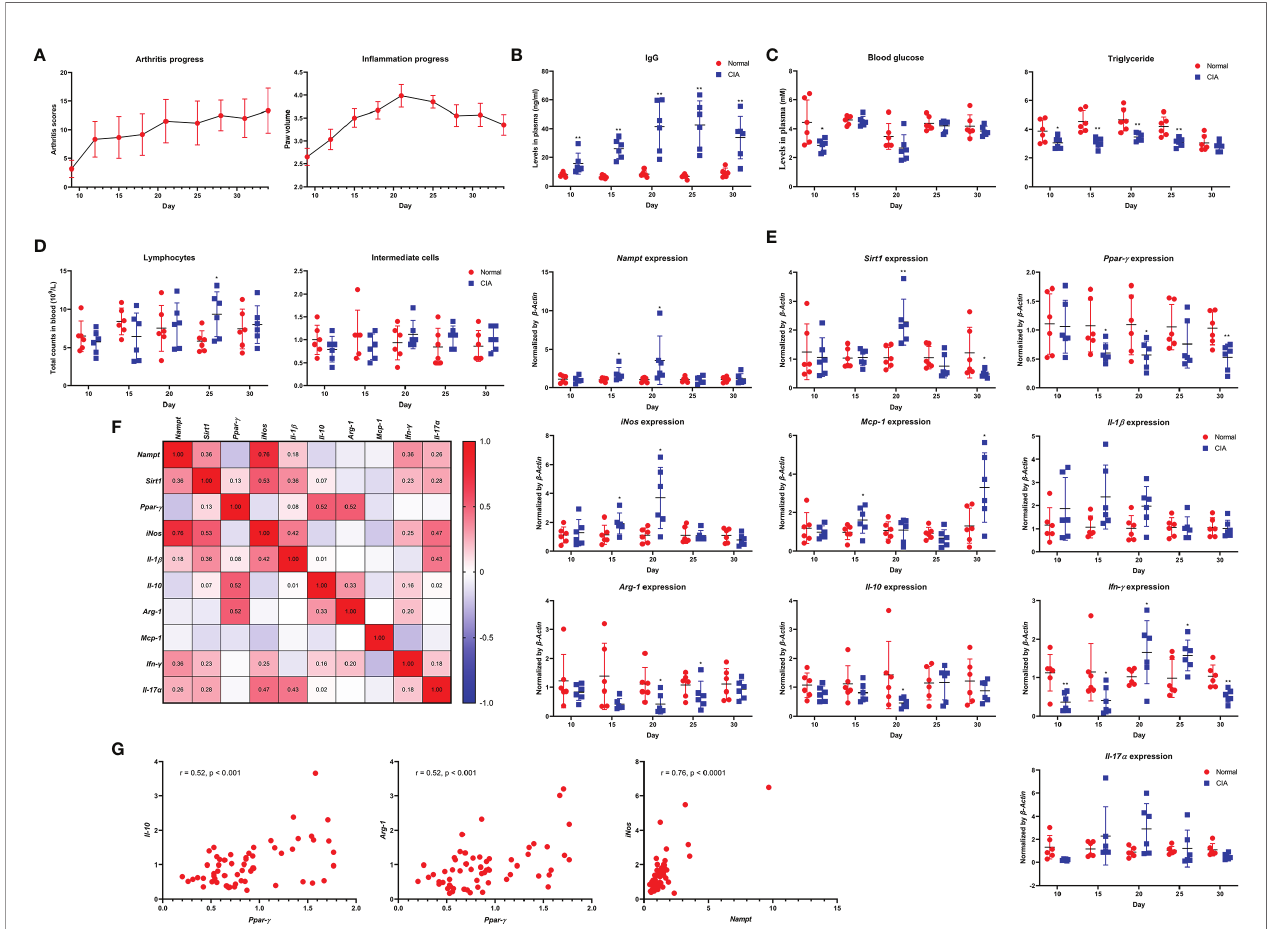
FIGURE 1 | Dynamic changes of Nampt expression and in fl ammatory indicators throughout the course of CIA in male SD rats feed under normal environment. (A) periodic changes of arthritis scores and hind left paw volume; (B) IgG level changes in blood; (C) blood glucose and triglyceride level changes in blood; (D) lymphocyte and intermediate cell count changes in blood; (E) mRNA expression of Nampt and other in fl ammatory genes in peripheral WBCs; (F) expression correlations among different genes; (G) key correlations demonstrated in scatter plots diagrams. Statistical signi fi cance: *p < 0.05 and **p < 0.01 compared with normal healthy